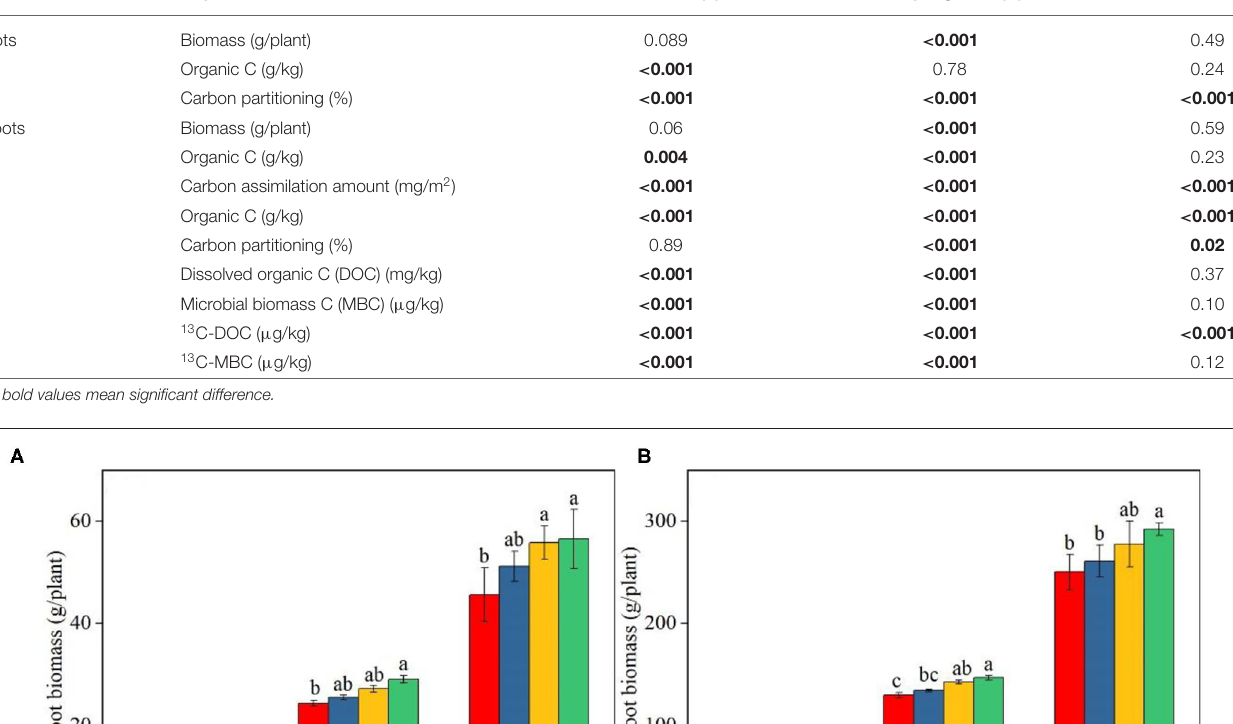
C in shoots ( Table 2 ). On 13 July, deep and shallow straw incorporation significantly increased C in shoots